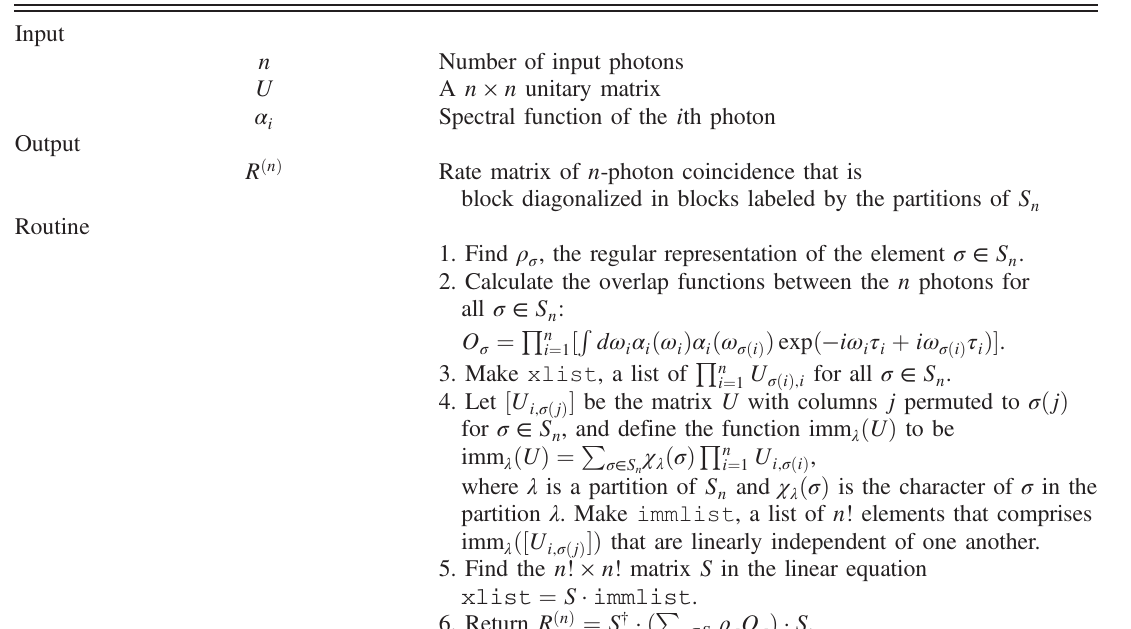
TABLE II. Algorithm to block diagonalize the rate